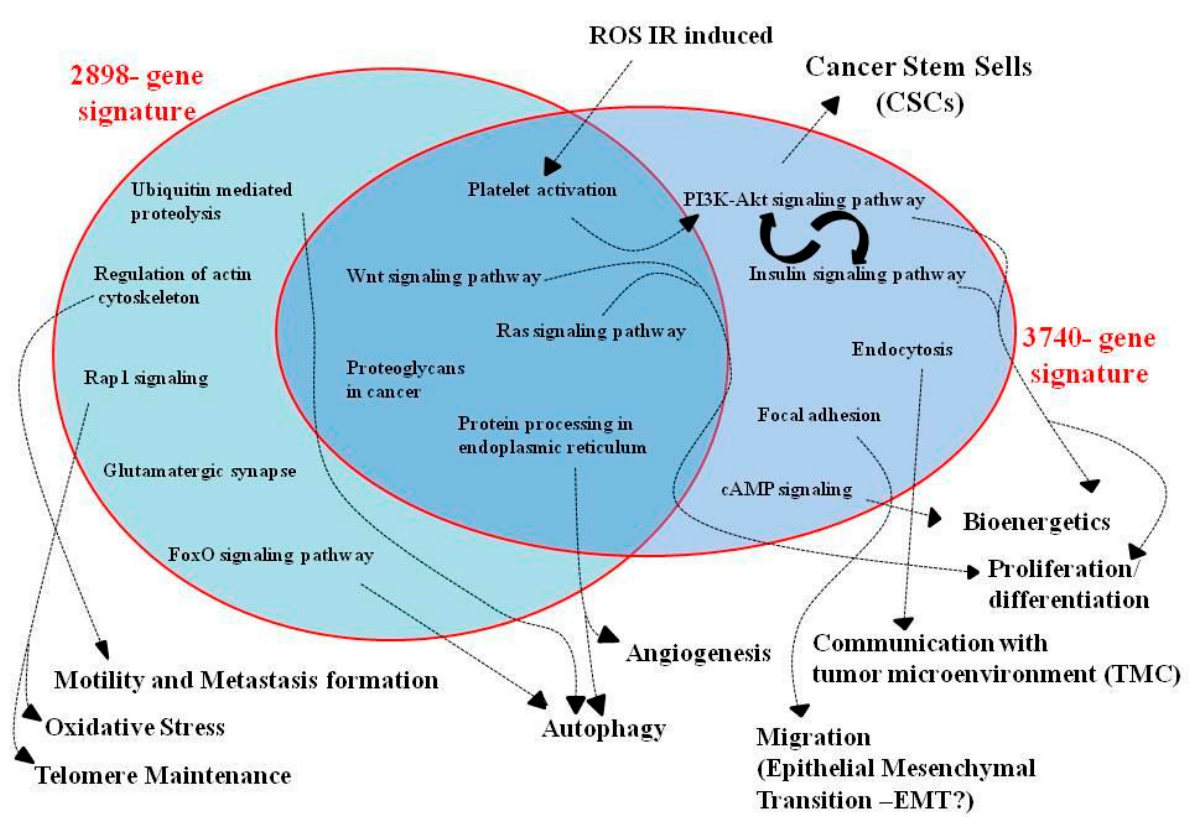
Figure 4. The figure summarizes the main intracellular networks of the 2898- and 3740-gene signatures highlighted in this work as activated in U87 GBM cells after hypoxia and PT work as activated in U87 GBM cells after hypoxia and PT exposure.